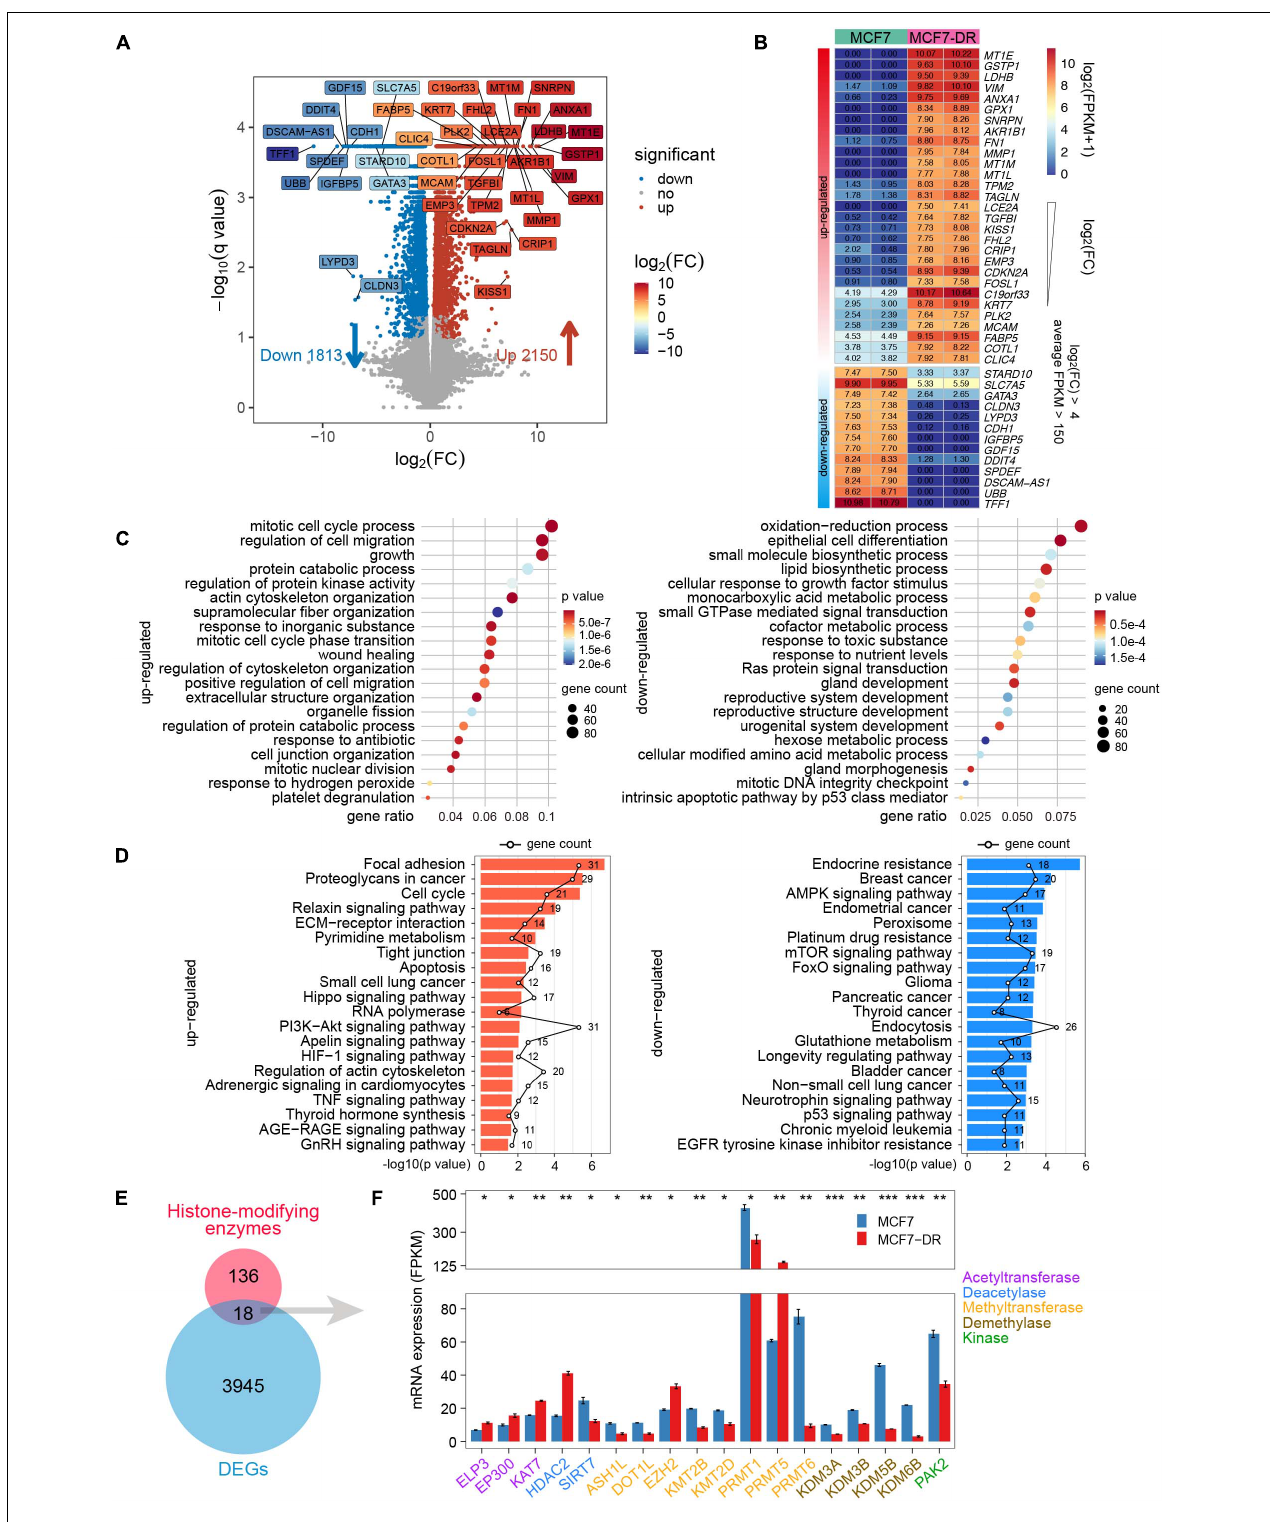
FIGURE 1 | Identification of key genes and functional characteristics analysis. (A) Volcano plot showing the transcript levels of differentially expressed genes (DEGs) between the parental and doxorubicin-resistant MCF7 cells. Significantly up-regulated 2,150 genes are shown as red dots, whereas 1,813 down-regulated genes are shown as blue dots. Filtered by q value < 0.05, absolute log 2 (FC) > 4 and average FPKM > 150, 42 significantly up- and down-regulated genes are highlighted